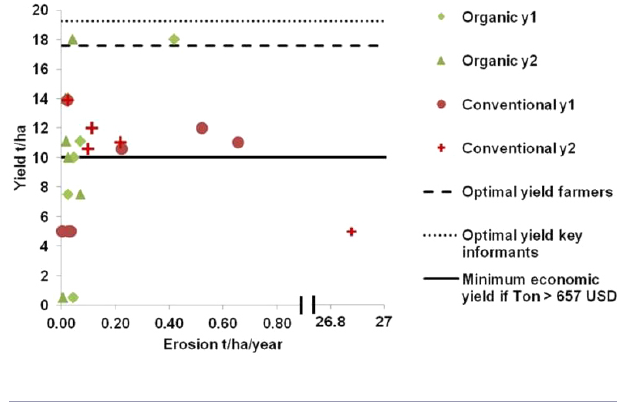
Fig. 3. Trade-offs between avocado yield and soil erosion in avocado agroecosystems on the P’urhépecha plateau, Mexico.